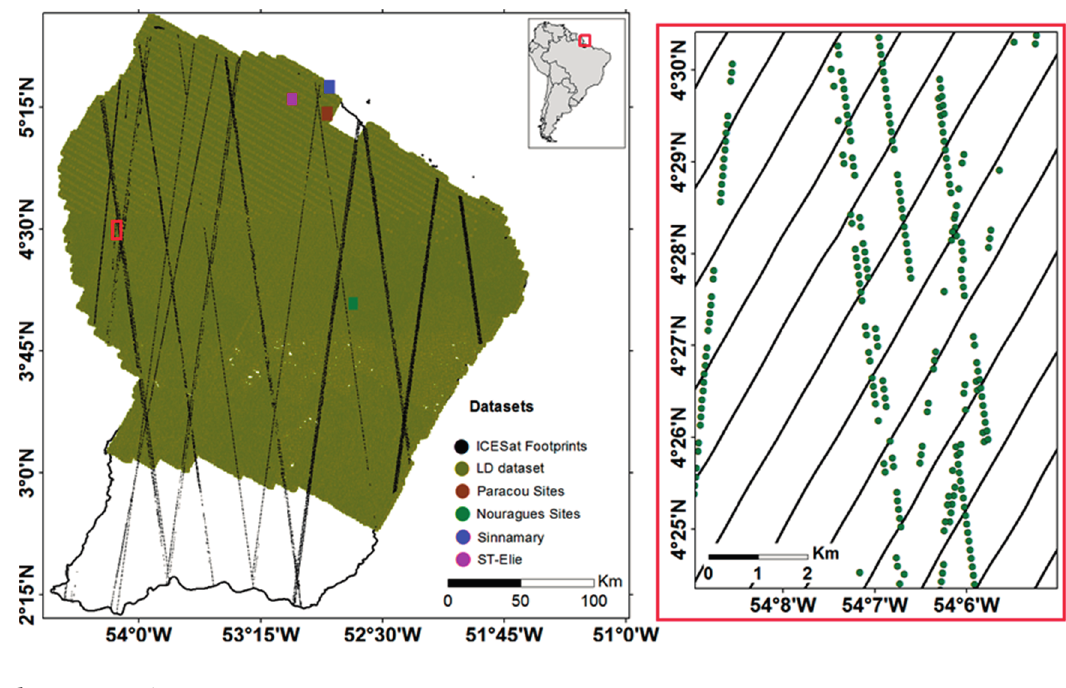
Figure 1. LiDAR datasets acquired for French Guiana (the right image corresponds to the red rectangle in the left